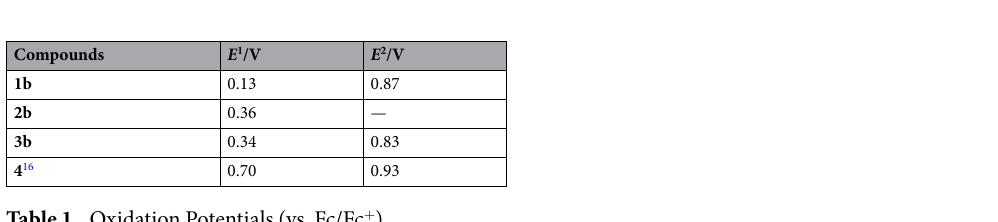
Table 1. Oxidation Potentials (vs. Fc/Fc + ).